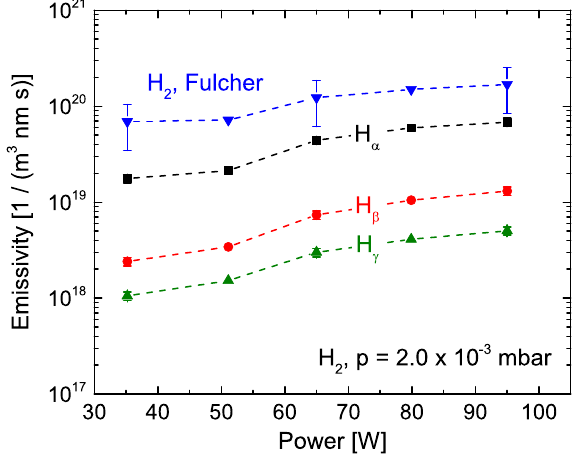
FIG. 4. Emissivities of the atomic Balmer lines (H α to H γ ) and of the integral between 600 and 640 nm taken as representative for the molecular Fulcher transition for a variation of the microwave power at fixed pressure of 2 . 0 × 10 − 3 mbar and fixed ¼ 0 . 56 . =B ratio B min ECR